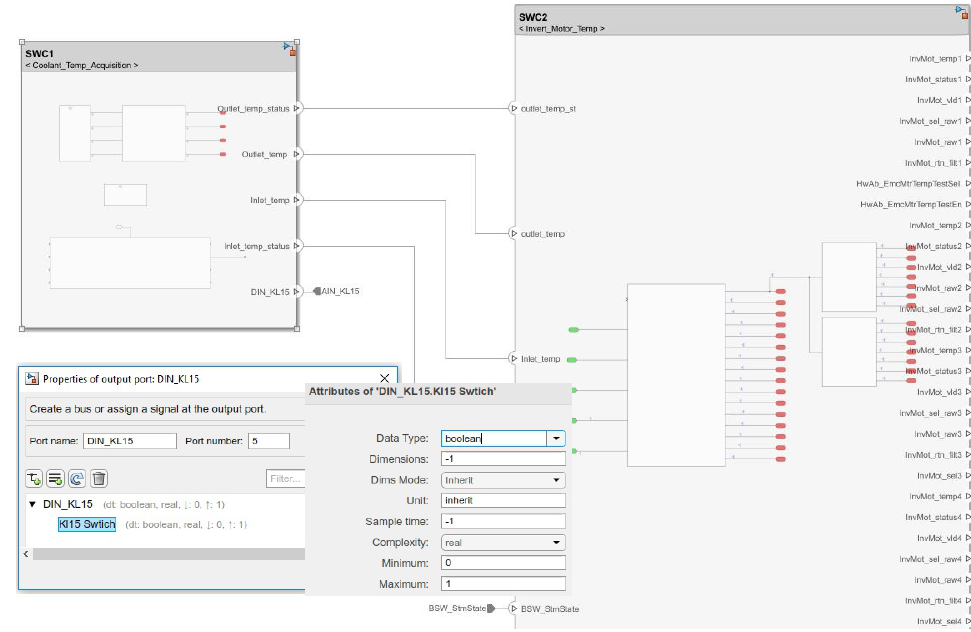
Figure 5. Architecture design using System Composer and AUTOSAR blockset in M/S with data dic-